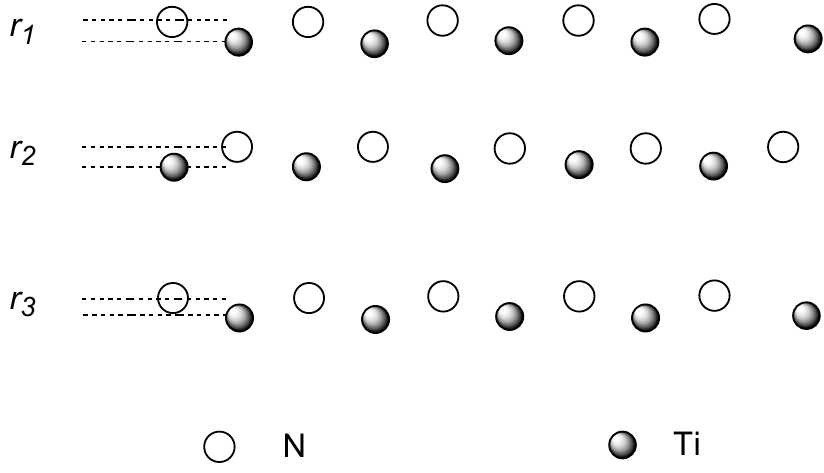
Figure 2. Schematic view of the rippled